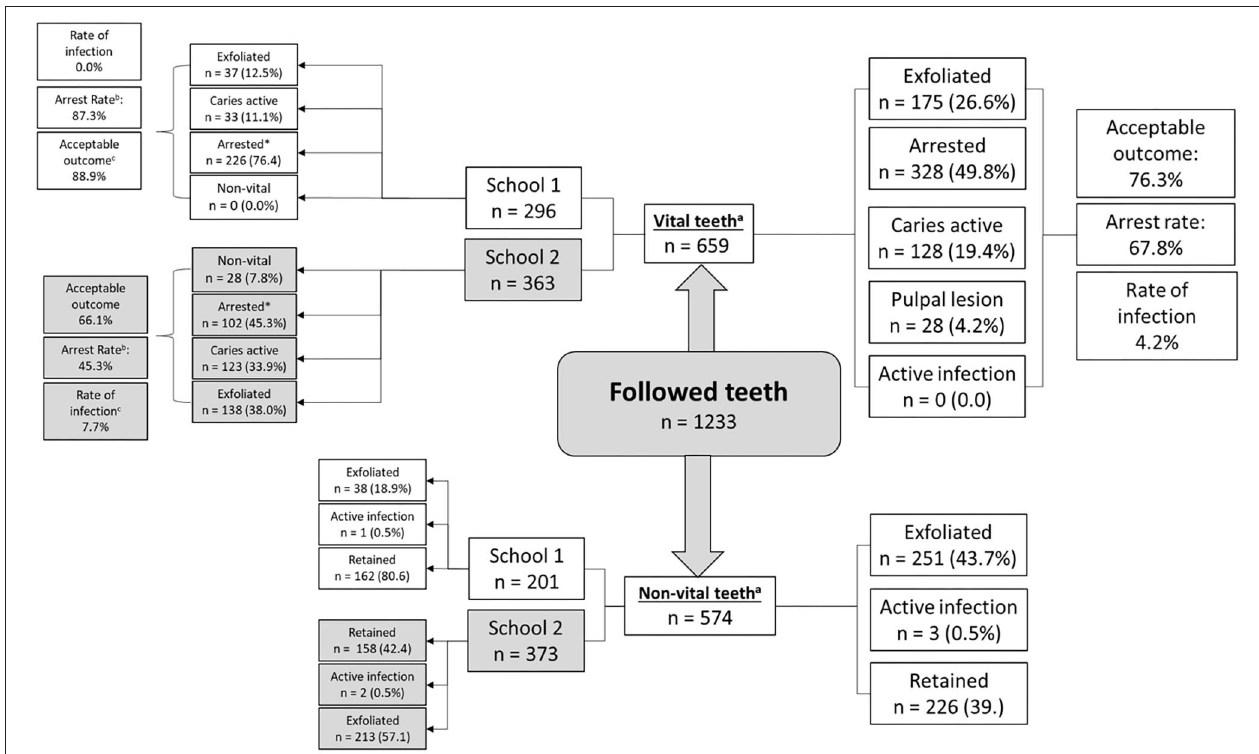
FIGURE 2 | Tooth-level outcomes by baseline lesion description and school membership. a P -value for difference in the proportion of cavitated and pulpally involved lesions ≤ 0.001; chi squared test. b P -value for difference in arrest rate by school ≤ 0.001; chi squared test. c P -value for difference in rate of infection by school membership ≤ 0.001; chi squared